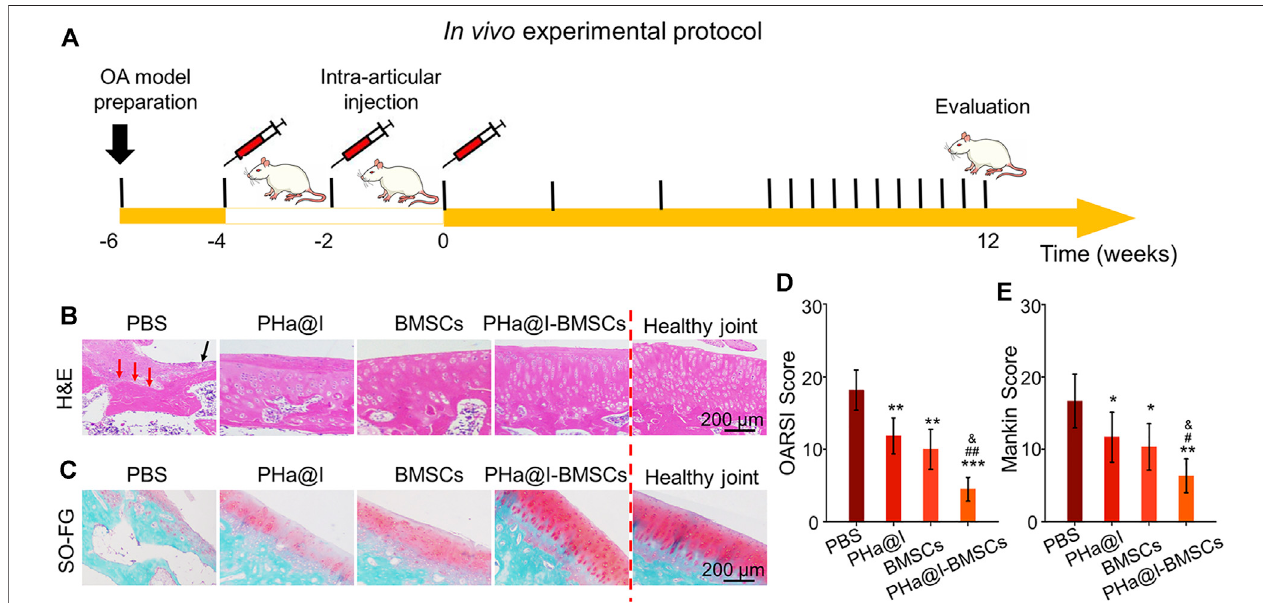
FIGURE 5 | Intra-articular injection of BMSCs incorporating PHa@I hydrogels reduce cartilage degeneration in osteoarthritis (OA). (A) Timeline of in vivo experimental protocol. (B) Hematoxylin eosin (H&E) staining of articular cartilage at 12 weeks after intra-articular injection. (C) Safranin O-fast green staining of articular cartilage at 12 weeks after intra-articular injection. (D) Osteoarthritis Research Society International (OARSI) scores were statistically analyzed in each group. (E) Markin scoreswerestatisticallyanalyzedineachgroup(* p < .05,** p < .01,and*** p < .001comparedwiththePBSgroup; # p < .05and ## p < .01comparedwiththePHa@I Group; & p < .05 compared with the BMSC Group, n =